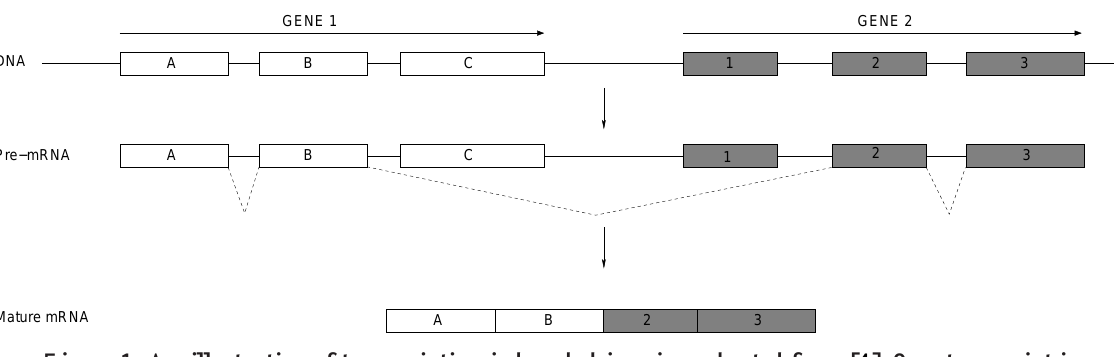
Figure 1: An illustration of transcription-induced chimerism adapted from [4]. One transcript is produced from two adjacent genes and the intergenic region is spliced out. The resulting mRNA sequence is known as a chimeric transcript or transcription-induced chimera. The boxes are exons and the dotted lines show where the pre-mRNA is spliced. The arrows above the genes indicate the direction of